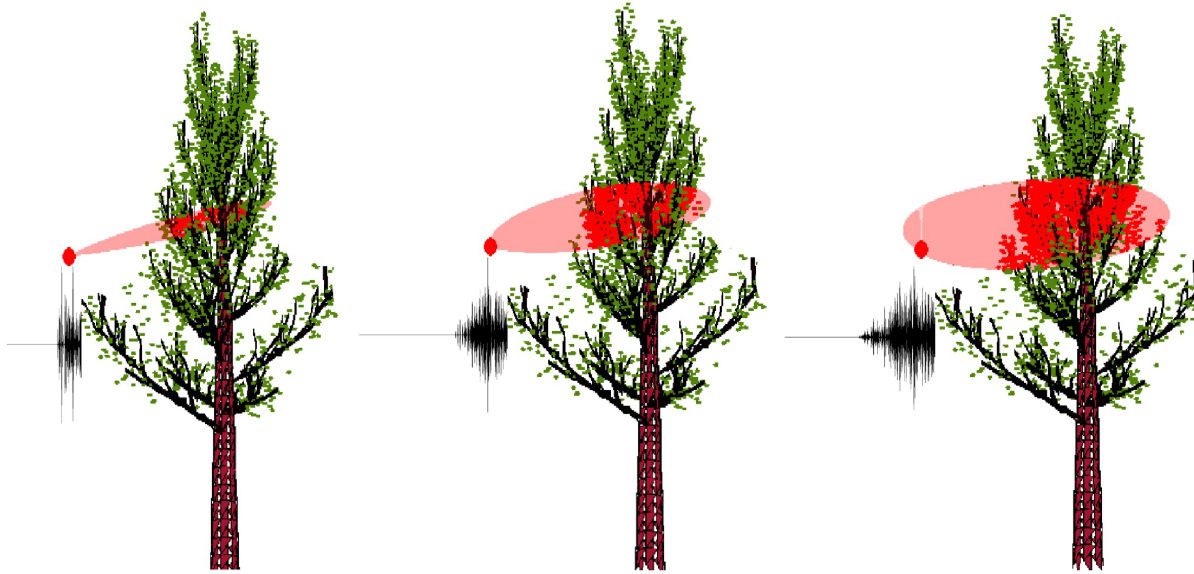
Fig 6. Simulated scenario I. A static sonar with varying beamwidths at 10, 30, 50 degrees (left to right). Red regions highlight the -3 dB contour of the sonar beam. Waveforms of the impulse responses were plotted on the left side of the 2-D view below the sonar location.